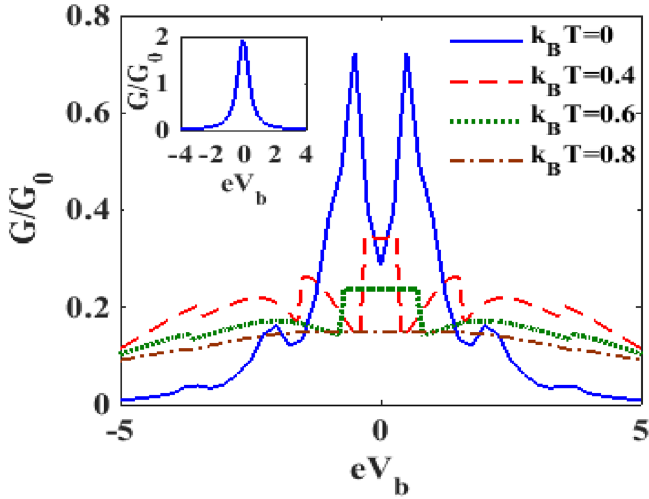
Figure 11. G / G 0 versus eV b for different values of k B T at (cid:31) = 0.6, eV m = 0.5, γ = 0.02 .